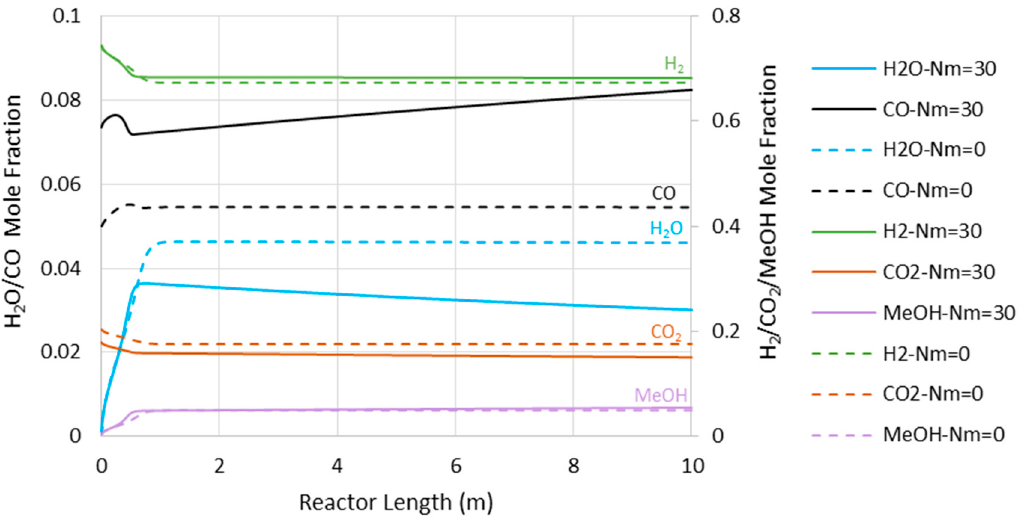
Figure 6. Species’ concentration profiles through the adiabatic reactor’s length at 7500 kPa (Nm = 0 corresponds to CR).